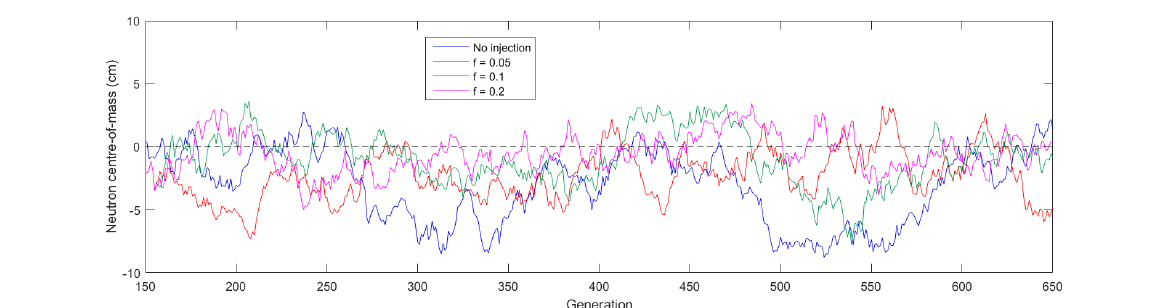
Figure 3: Neutron centre-of-mass for the vacuum-boundary PWR pin when varying the particle injection